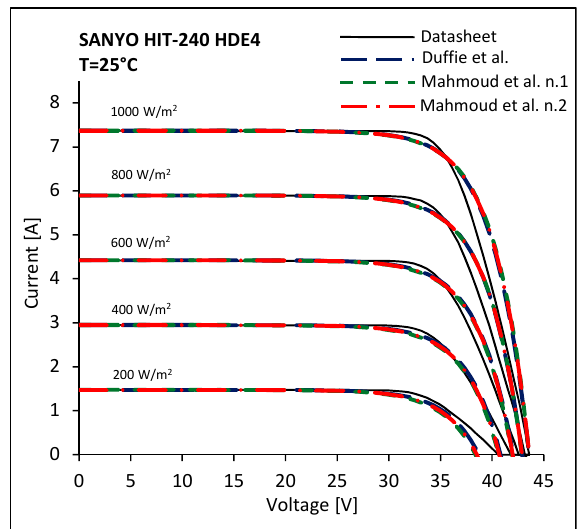
Figure 10. Comparison between the issued I-V characteristics of the Sanyo HIT-240 HDE4 at T = 25 °C and the characteristics calculated by means of the Duffie et al. and the Mahmoud et al. models.